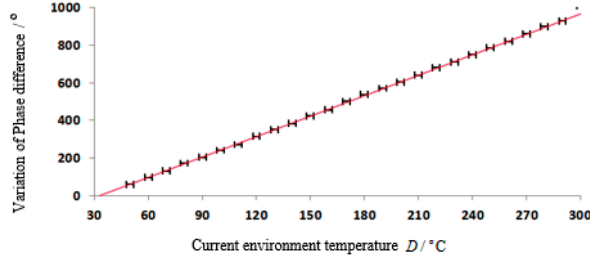
φΔ and D in the VNA test. 13